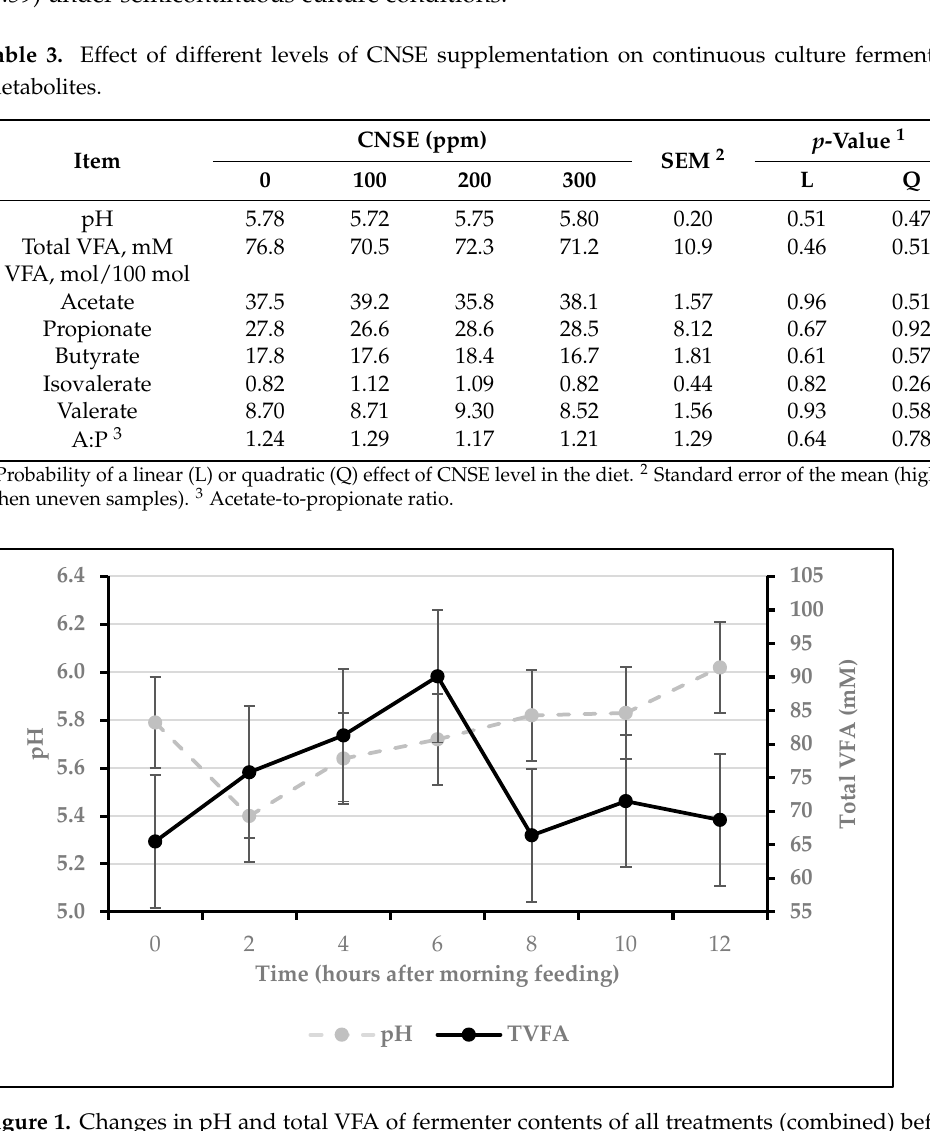
Figure 1. Changes in pH and total VFA of fermenter contents of all treatments (combined) before (0 h) and every two hours after the a.m. feeding on d 10. Bars indicate SEM.